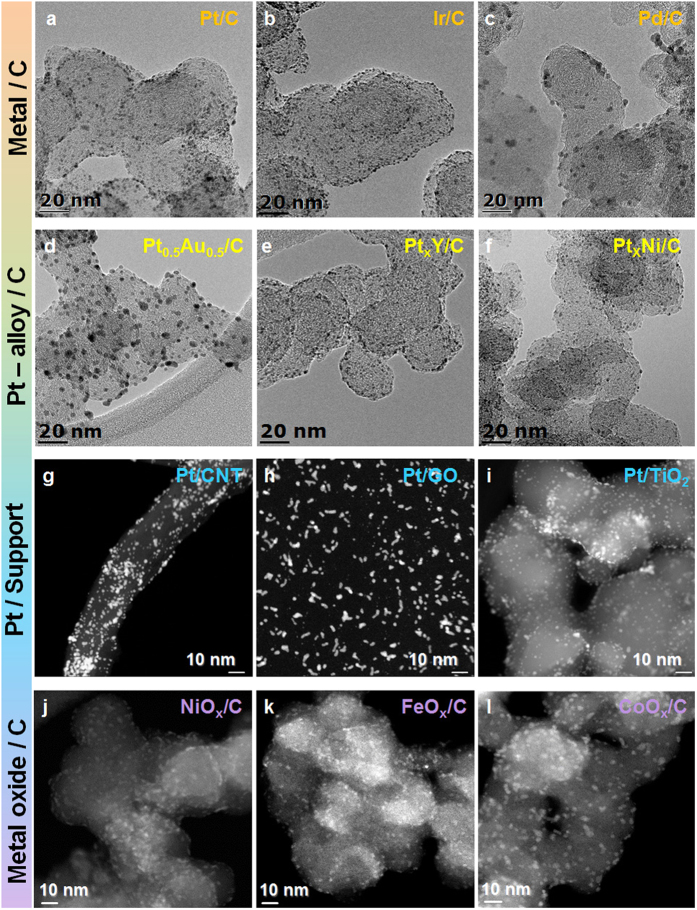
TEM images of NPs deposited on various high surface area supports prepared using NP/Glu.(a) Pt/C, (b) Ir/C, (c) Pd/C, (d) Pt0.5Au0.5/C, (e) PtxY/C, (f) PtxNi/C, (g) Pt/CNT, (h) Pt/GO, (i) Pt/TiO2, (j) NiOx/C, (k) FeOx/C, and (l) CoOx/C.